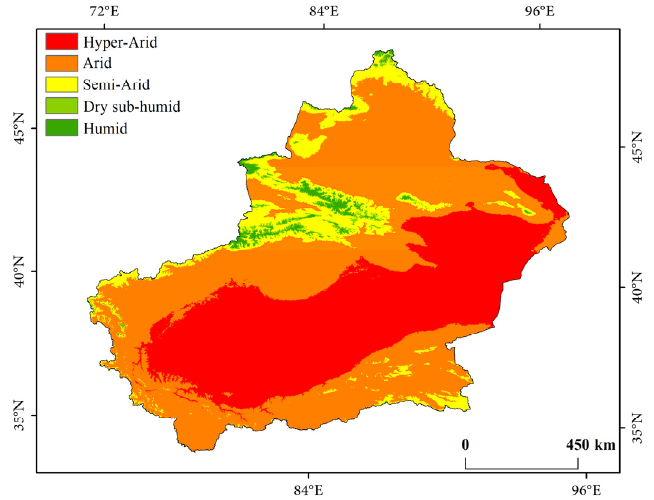
Figure 3. The classification map of climate zones based on the aridity index in